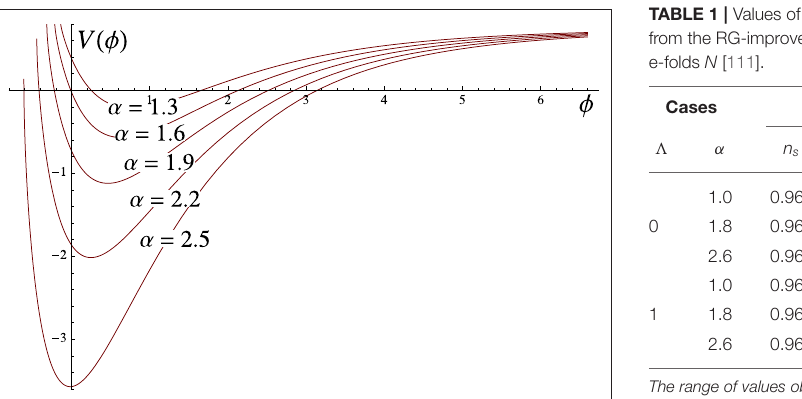
( φ ) for 3 1.4 and various = + [1,3] [ 60, 111]. This is the ∈